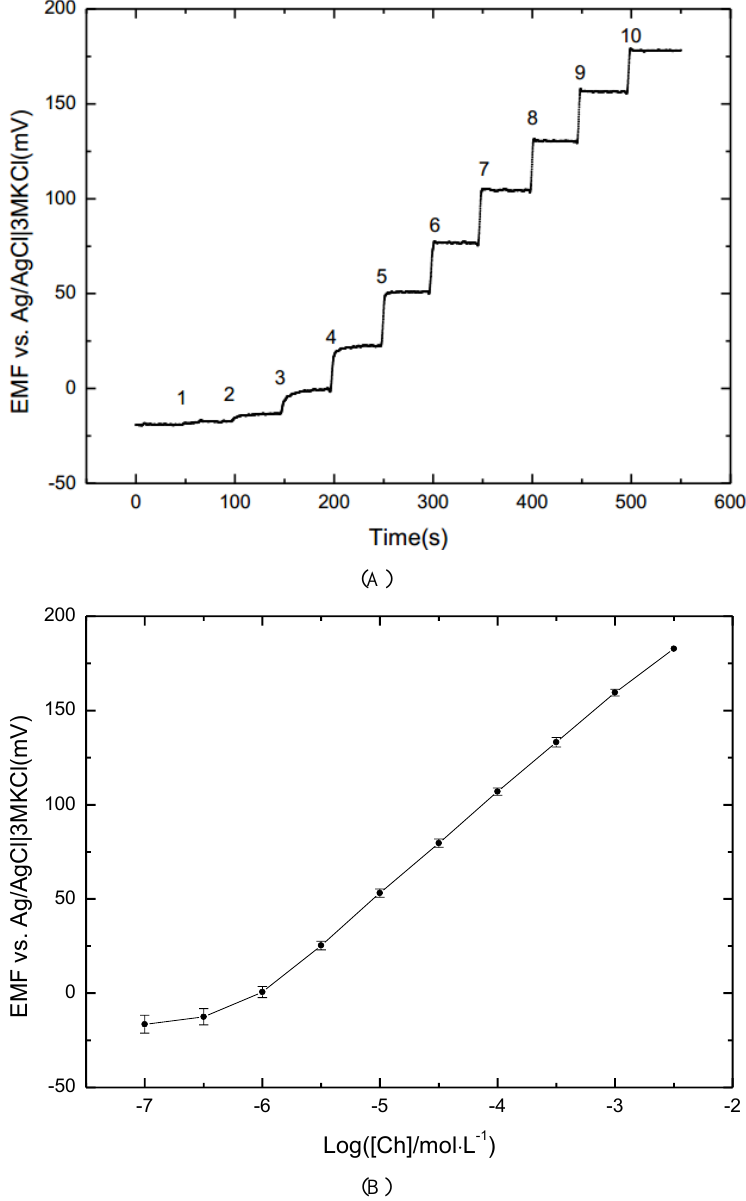
Figure 3. ( A ) Dynamic responses with the addition of ChCl stock solutions every 50 s (1: 10 − 7 M; 2: 3 × 10 − 7 M; 3: 10 − 6 M; 4: 3 × 10 − 6 M; 5: 10 − 5 M; 6: 3 × 10 − 5 M; 7: 10 − 4 M; 8: 3 × 10 − 4 M; 9: 10 − 3 M; 10: 3 × 10 − 3 M); and ( B ) calibration curve of ChCl solutions with a concentration in the range from 10 − 7 M to 3 × 10 − 3